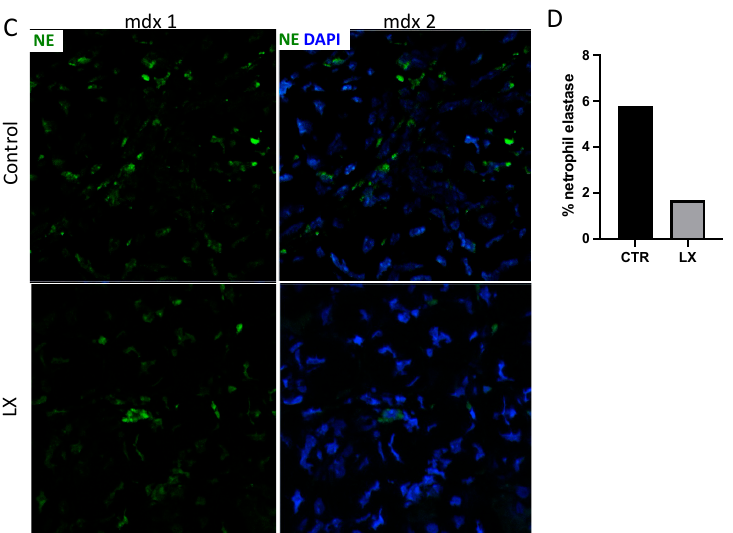
Figure 4. LX2931 perinatal treatment reduces skeletal muscle inflammation in mdx mice. ( A ) Immunofluorescence microscopy detecting hematopoietic cell infiltrates in skeletal muscle ( tibialis anterior ) of LX2931-treated (LX) and control (CTR) mdx pups. Anti-SPL antibody marks SPL in red. CD45 marks hematopoietic cells in green. DAPI labels nuclei in blue. Muscles from two LX2931-treated (LX) and two control (CTR) mice are shown for comparison. ( B ) Quantitation in percentage of CD45+ fluorescent area/low power field of images in A. ( C ) Neutrophil infiltration in skeletal muscle of LX2931-treated (LX) and control (CTR) mdx pups. Neutrophil elastase (NE) marks neutrophils in green. DAPI labels nuclei in blue. ( D ) Quantitation of neutrophil elastase of images in C. Magnification = 400×.